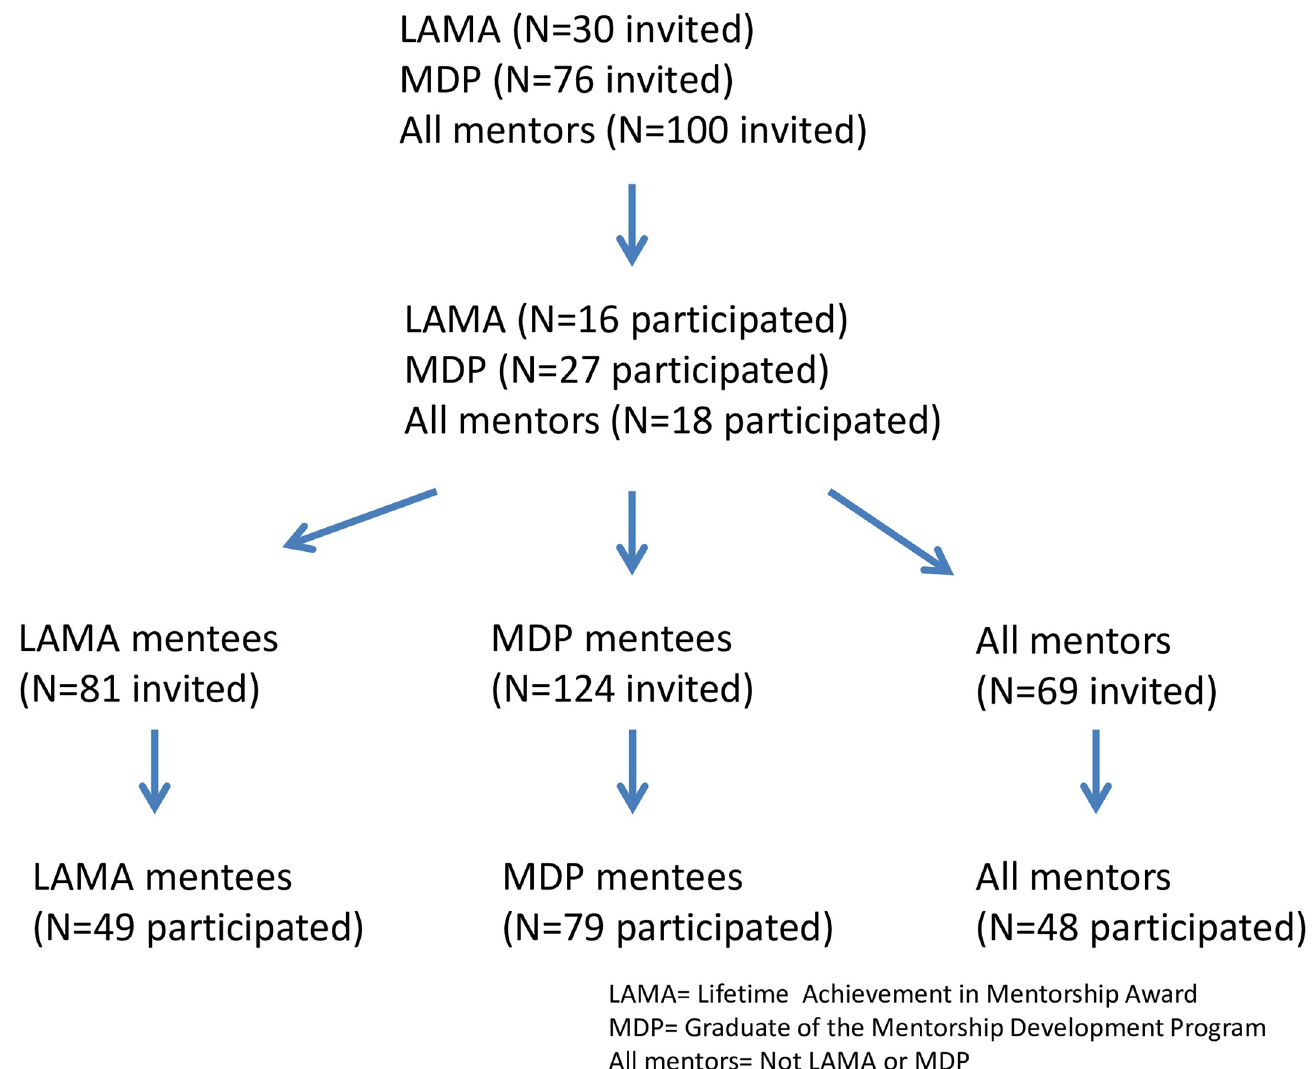
Fig 2. Recruitment flow